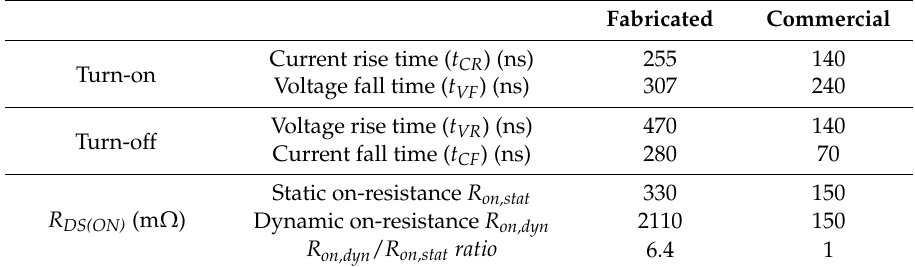
Figure 11. ( a ) Turn-on and ( b ) turn-off switching transients of the commercial [TPH3006PS] (fine colored lines) and fabricated (bold colored lines) GaN FETs (Simulation: black line). Table 3. Switching time and energy loss between the fabricated and commercial GaN FETs [TPH3006PS].